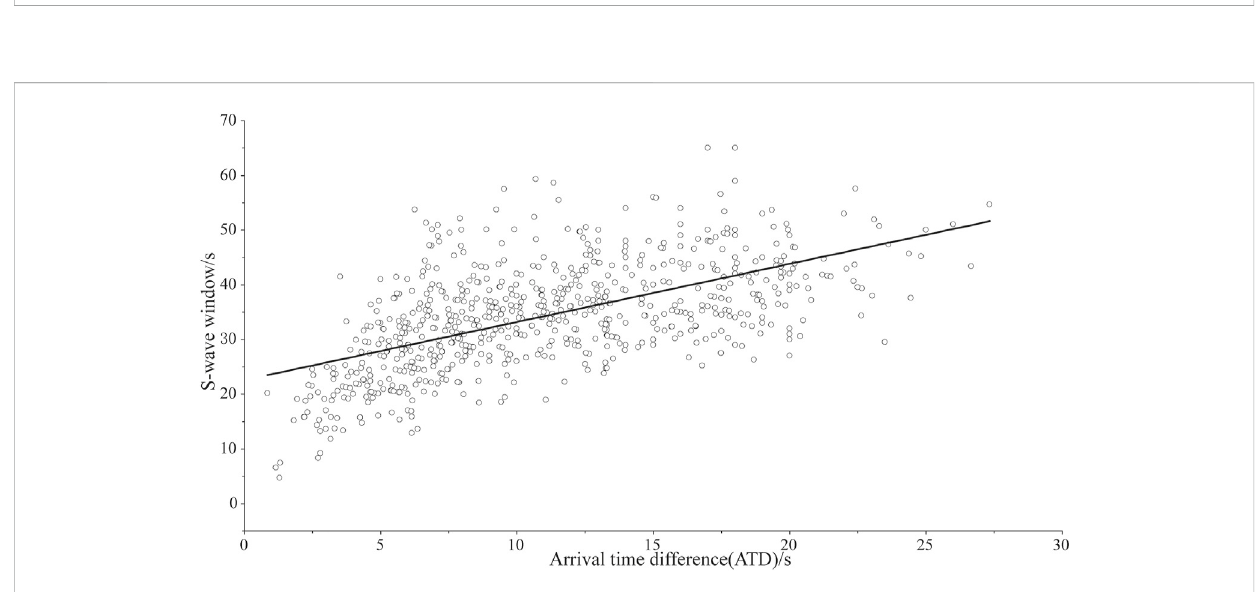
FIGURE 3 Graph showing the fi tted relationship between the S-wave window and epicentral